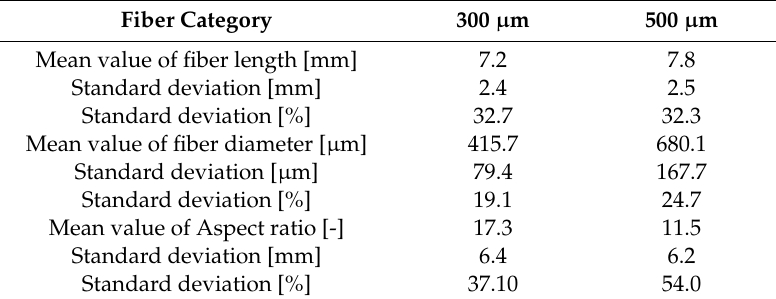
Table 1. Geometry of the bamboo fibers.